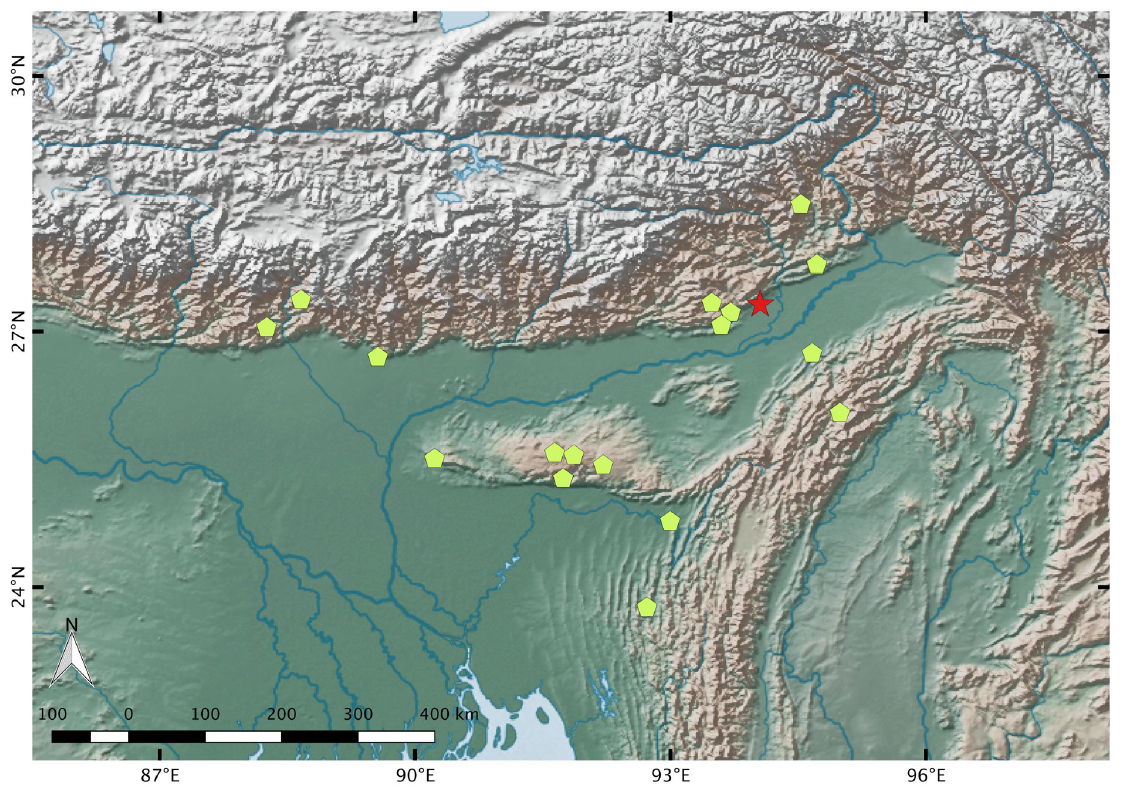
Fig. 9. Map of Northeast India, showing the distribution records of Ahaetulla flavescens (Wall, 1910) comb. nov.; red star represents the type locality